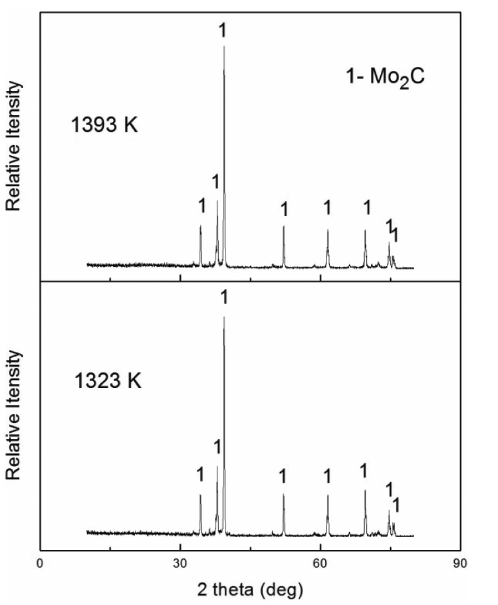
Fig. 9: XRD patterns of MoO 2 powders reduced by CO for 100